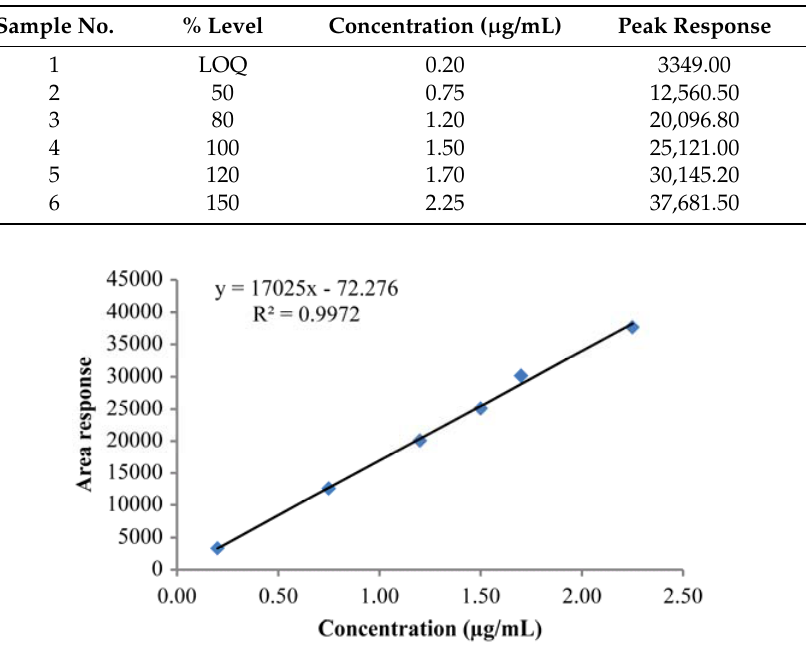
Figure 3. Linearity plot for the S ‐ enantiomer (RAS ‐ III).